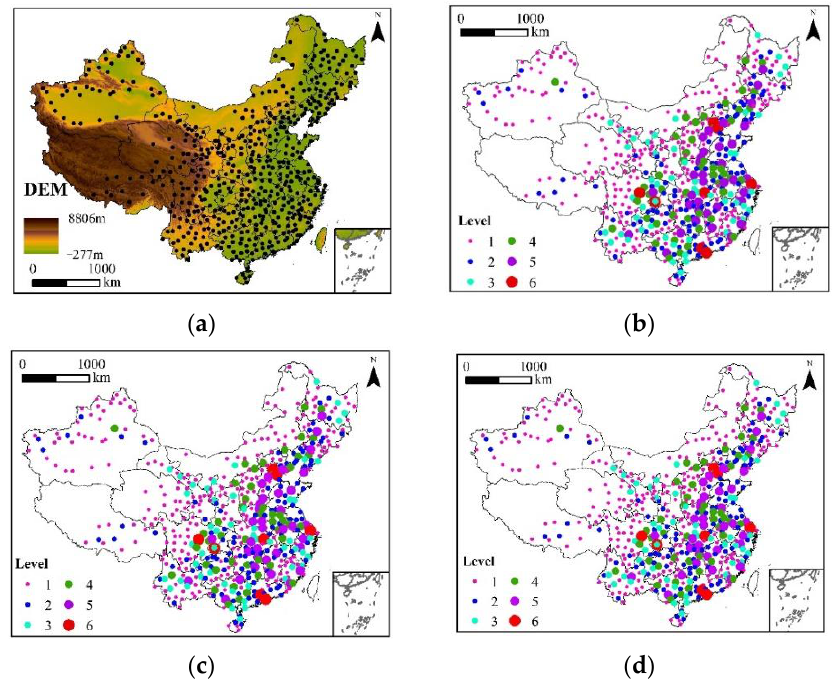
Figure 1. The spatial distribution of digital elevation (m), weather station, and SDLs based on population, GDP, or both (using data from 2018). ( a ) Elevation and weather station locations. ( b ) SDL classification by population. ( c ) SDL classification by GDP. ( d ) SDL classification by population and GDP.